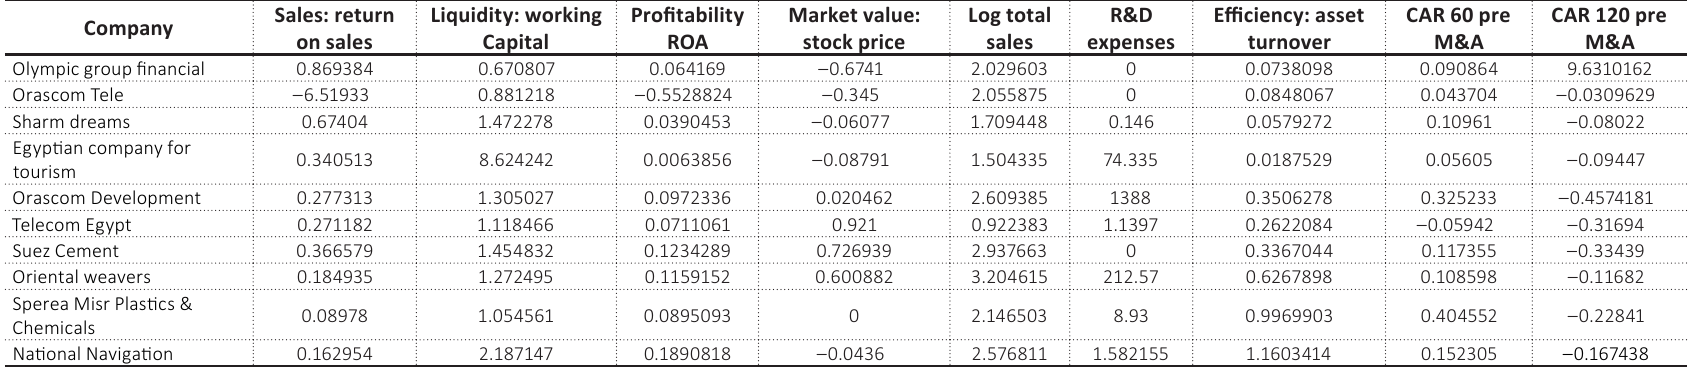
Table D1. Results for BSC and CAR